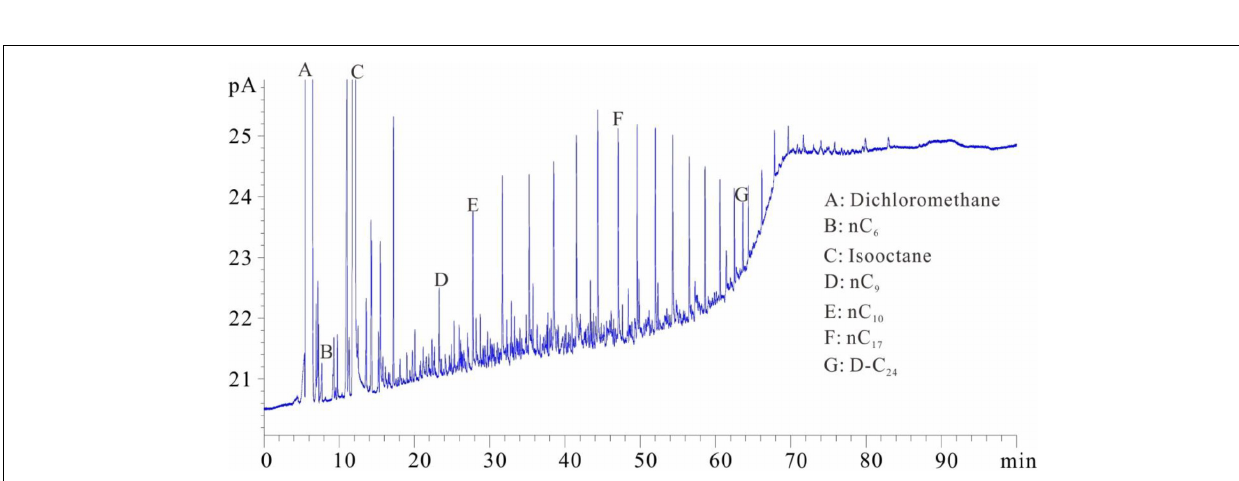
FIGURE 4 | Chromatogram of samples after dichloromethane extractions (chromatogram after step 4).